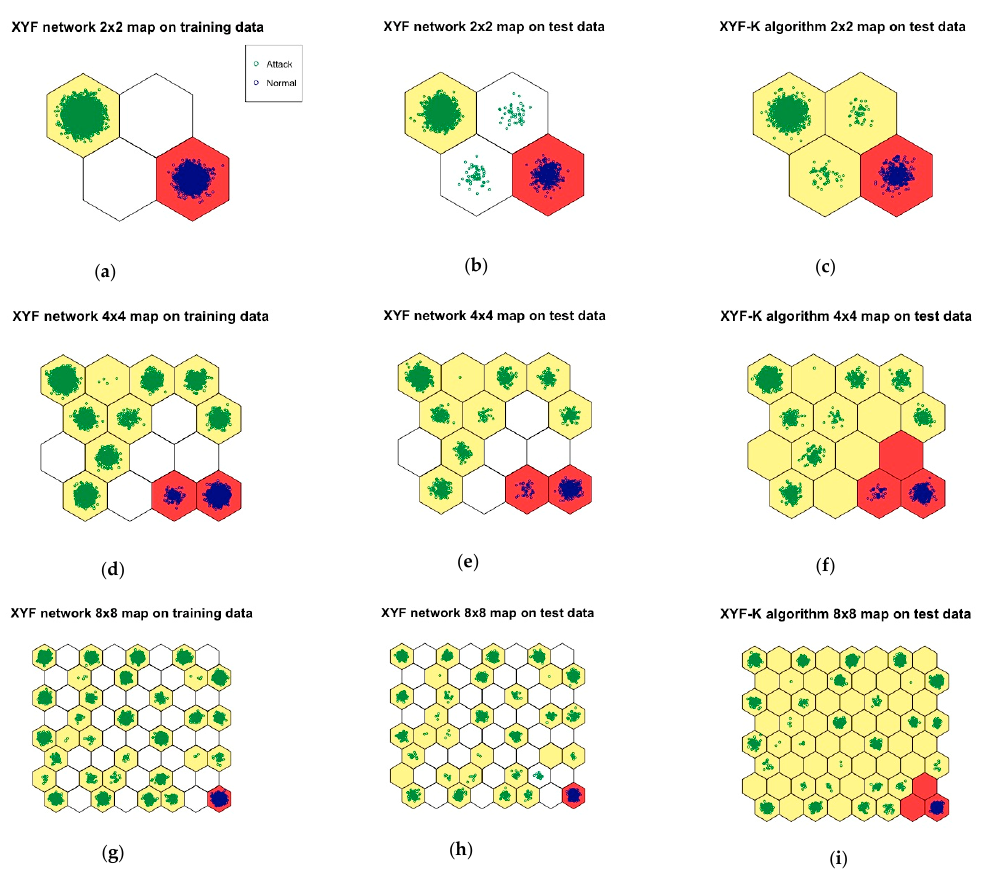
Figure 5. XYF network and XYF–K algorithm on the di ff erent neurons map sizes for the spoofing